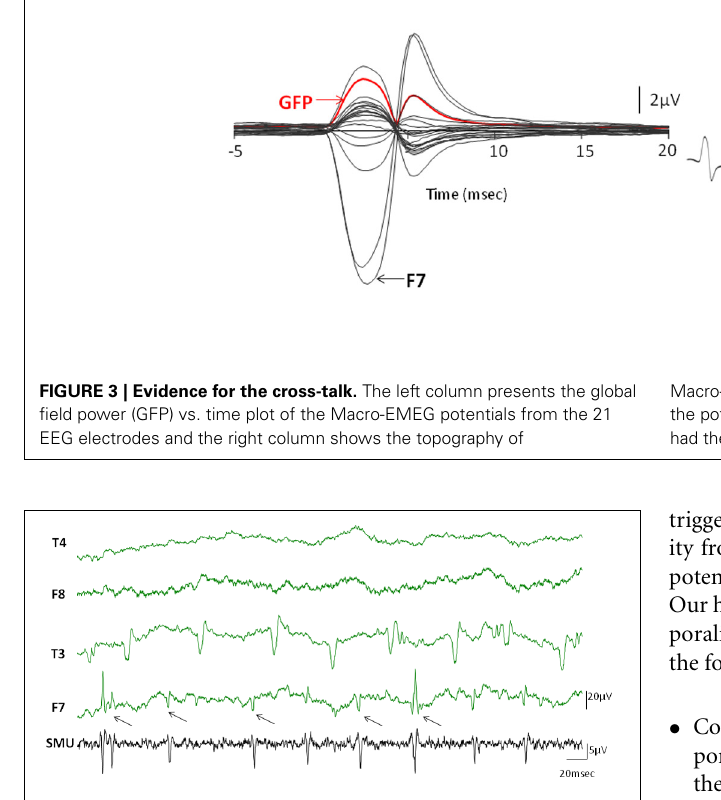
FIGURE 4 | Visible SMU spikes in EEG records. Clearly visible cross-talks of the SMU spikes occasionally appeared on the EEG channels during recording. Black arrows indicate cross-talks of the simultaneously recorded SMU spikes in the F7 electrode. Other clear spikes in the F7 and T3 electrodes may however belong to different simultaneously active motor units which were not in the recording range of our wire